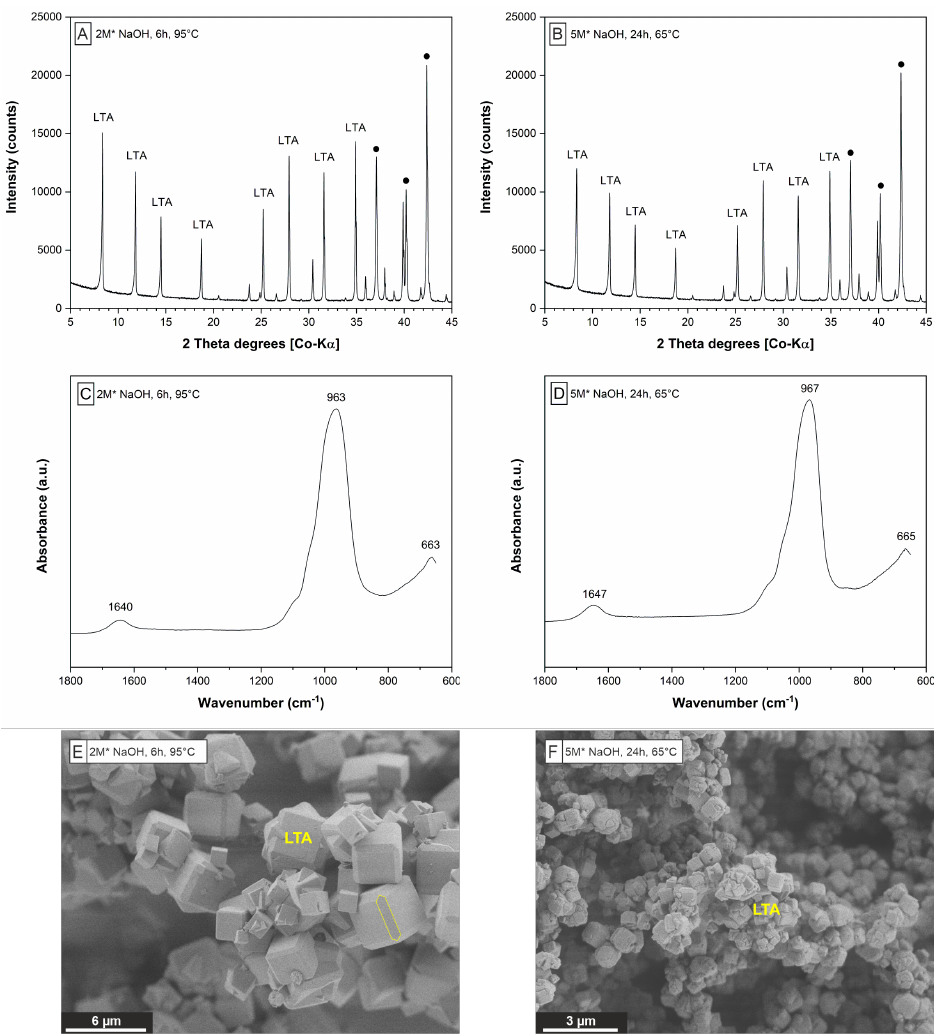
Figure 5. Characterization of zeolites obtained from the hydrothermal synthesis step 2. XRD patterns ( A , B ), FTIR spectra ( C , D ) and SEM-SEI ( E , F ) of solids obtained from experiments S2 and S4 reveal the formation of LTA-zeolites with chamfered edges (highlighted in E ). • —marks the peaks derived from the internal zincite